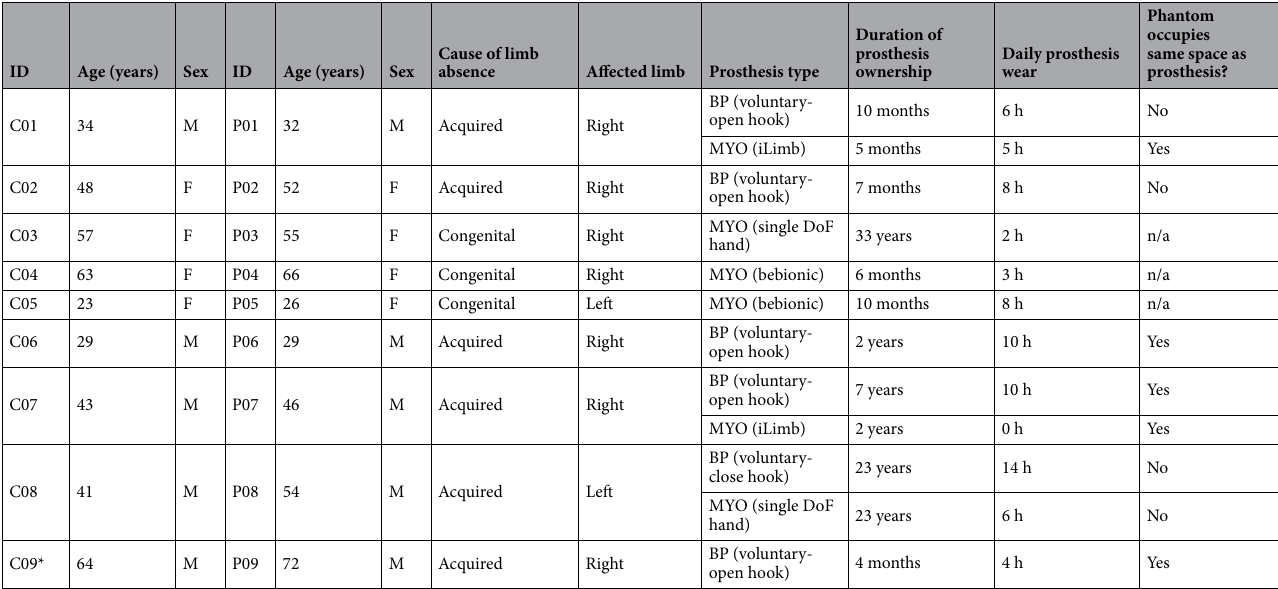
Table 1. Participant characteristics. *Data from C09 was excluded due to noncompliance with